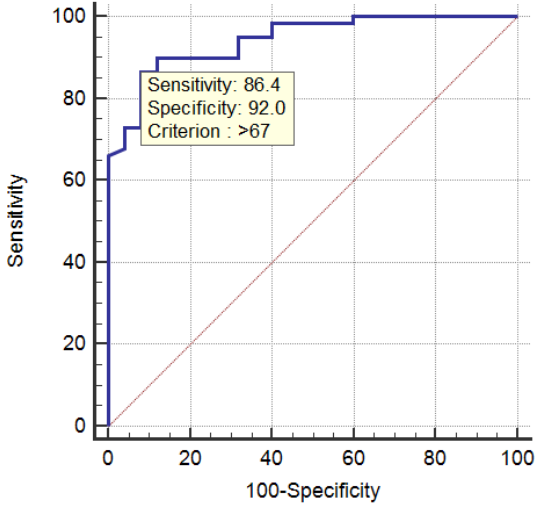
Figure 1. ROC curve of the sFtl-1/PIGF ratio in the diagnosis of PE.